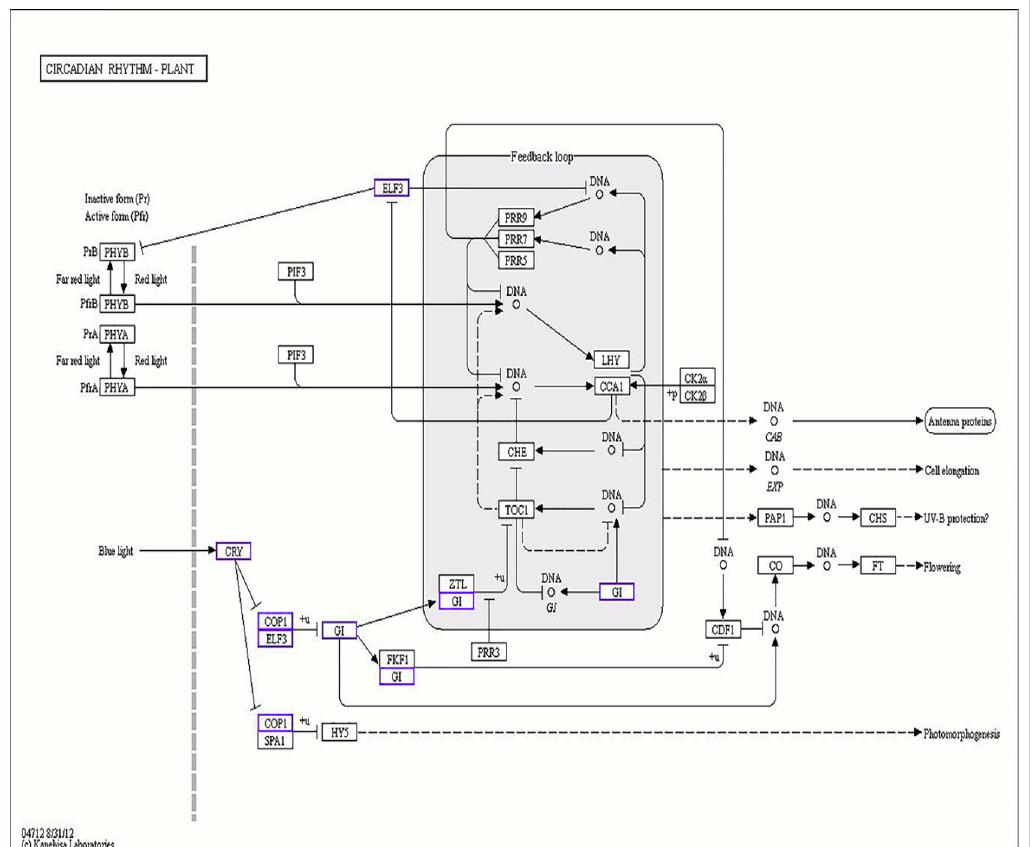
Figure 9. Network analysis of DEGs in the “circadian rhythm-plant” category. The small rectangular squares represent genes or proteins.The small dots represent chemical molecules. Straight lines and arrows represent activation. Dotted lines and arrows represent indirect effects. T-bars stand for inhibition. +u represents ubiquitination. +p represents phosphorylation. The purple squares represent DEGs enriched in this pathway in the comparison groups MM_1-vs-MM_2 and